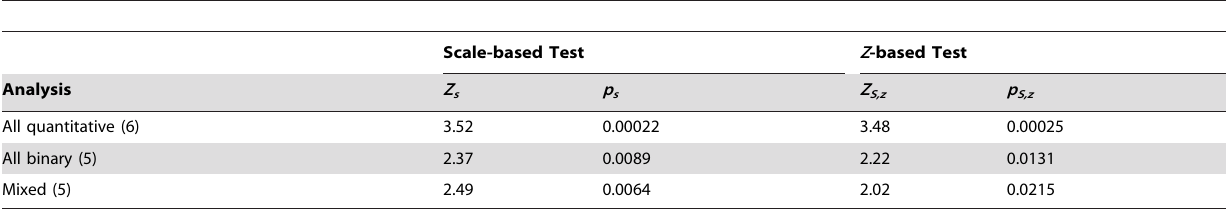
Table 3. The Wei-Lachin scale-based and Z-based one-directional multivariate test Z and one-sided p-values for three different analyses of the DPP metabolic syndrome